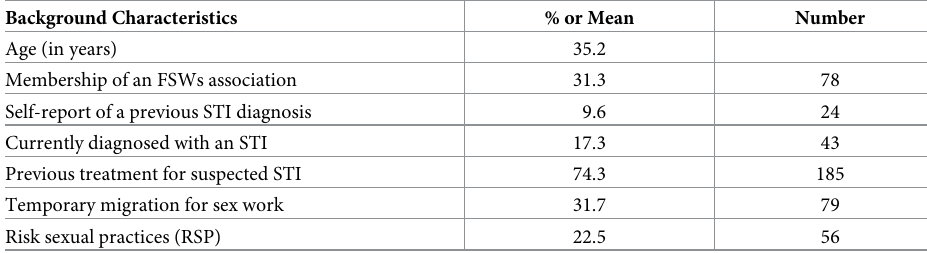
Table 1. Background characteristics of female sex workers, Quito,